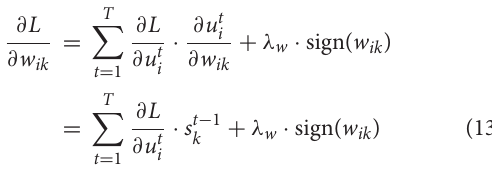
2, the influence of ε T , ε T − 1 , ε T − 2 are taken into account through iterative calculation, which only −